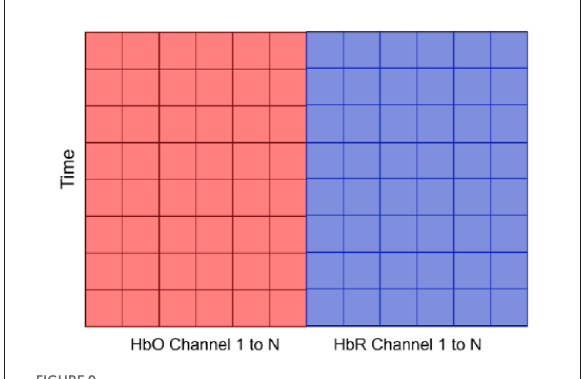
N channels where X 1 is the latest block of size WS , and this block slides one row in time (from row 1 to row M-WS ) till X M-WS . This gives an output of dimension [( M-WS ) × WS × N ] as shown in Figure 8 . For our study, we selected a window size of 50, which represents roughly 6 s of data for dataset A and 5 s for dataset B (open access). From the sliding window function’s output, each block’s dimension was computed as 1 × WS × N which is shown in Figure 9 where time is the WS and N is number of channels. Finally, this is labeled as “left,” “rest,” or “right” based on the experimental paradigm.